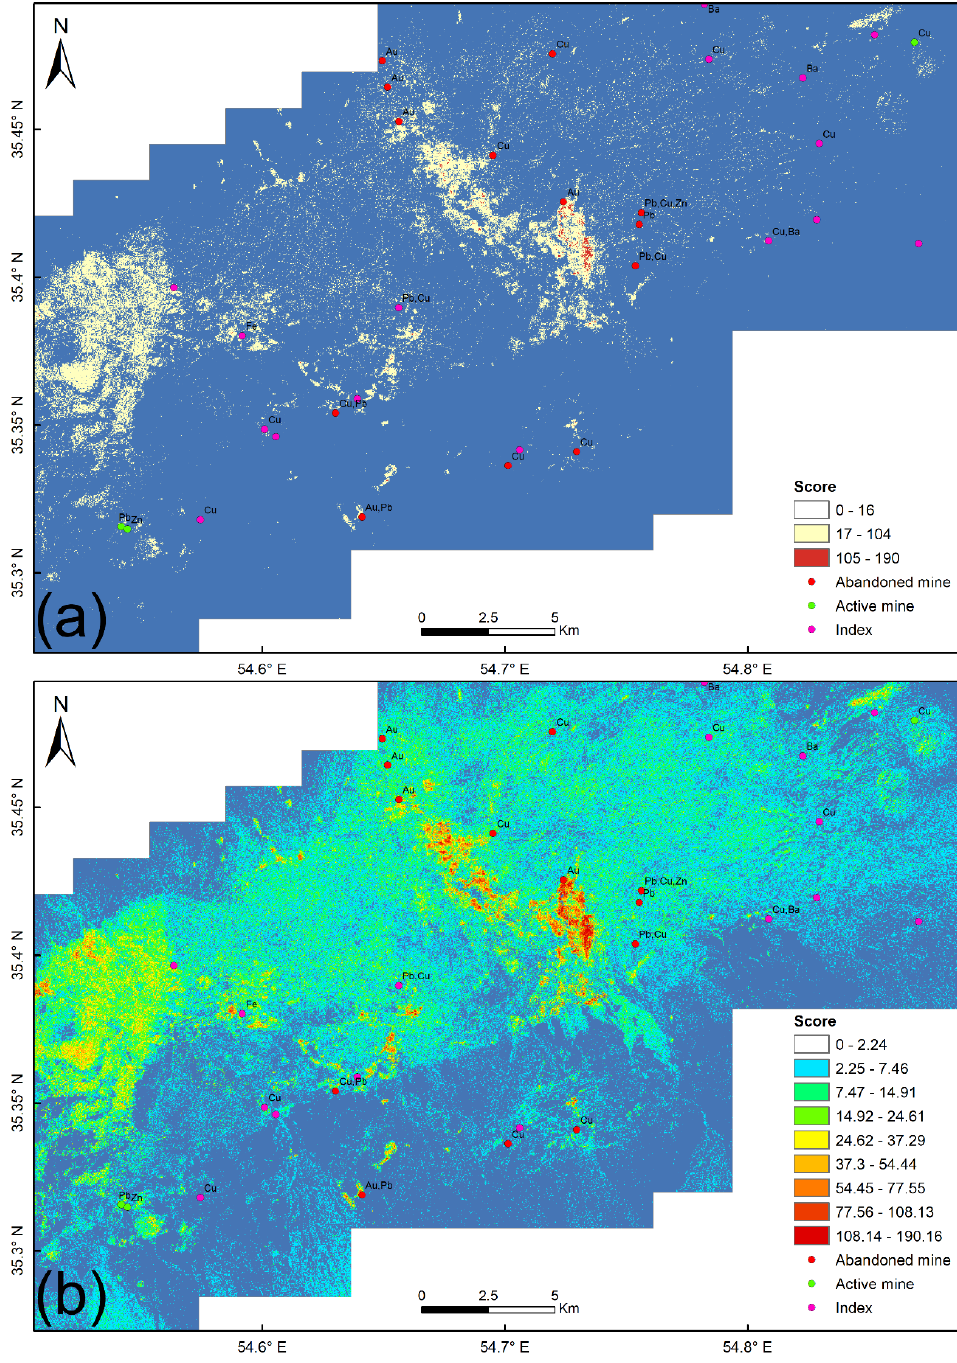
Figure 18. Known hydrothermal mineral occurrences overlaid on the classified integrated maps by ( a ) the C-A plot, and ( b ) Natural Jenks Breaks, generated by integrating the weighted-selected components.